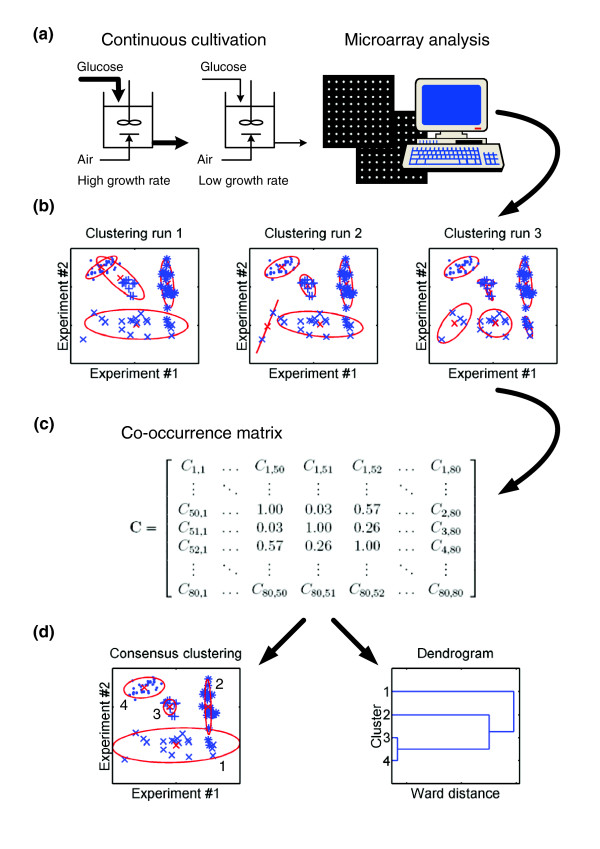
Experimental set-up. (a) Cells were grown at steady state in continuous chemostat cultures, with the specific growth rate controlled by the flow rate and the volume of medium in the reactor. Cells were harvested and used for transcription analysis and subsequent clustering of the transcription data. A simulated dataset was generated to illustrate the principles of consensus clustering. The dataset contained 80 members derived from four clusters (*, x, + and · in blue) in two experiments. The consensus clustering method consisted of three steps (panels b-d). (b) An ensemble of clusterings was obtained by multiple runs of mixture of Gaussians [59]. Each run gave very different results (red ellipses), depending upon the initialization. (c) The results from multiple runs was used to form the transcript co-occurrence matrix (C), which was calculated as the empirical probability (over all runs) of observing each pair of transcripts (n,n') in the same cluster. (d) Based on the co-occurrence of transcripts a consensus clustering was generated. The co-occurrence matrix was also converted into a transcript-transcript distance matrix as Dnn' = 1 - Cnn', which was used as input to a hierarchical clustering. The resulting consensus dendrogram showed the relationship between the clusters and was thereby a valuable tool in the biologic validation of the data.